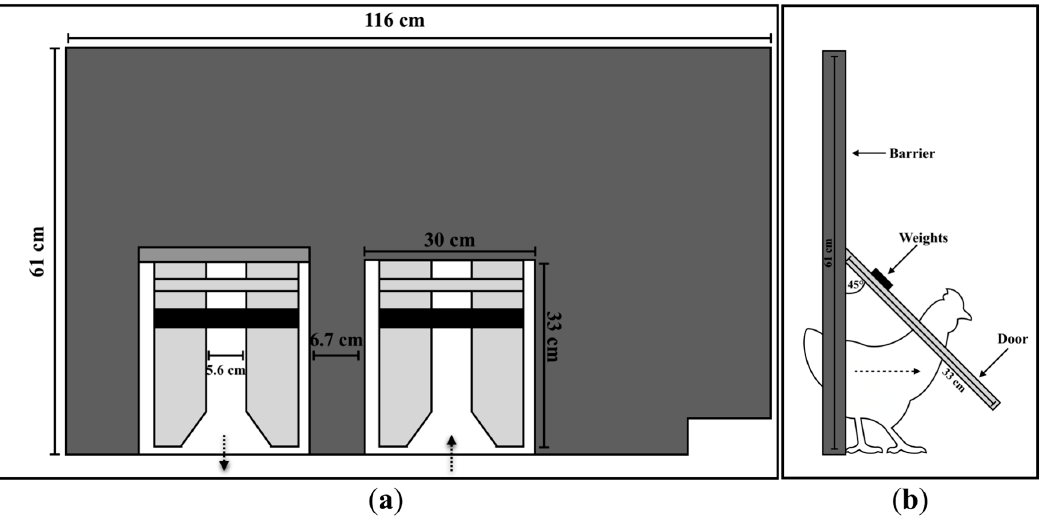
Figure 3. ( a ) Barrier layout with push doors viewed from chicks’ eye level. Each barrier contained two one-way push doors. Weights are shown as black bars that mount just above where the chicks’ heads would be when pushing the door. ( b ) The door rests on the chick’s shoulders as she pushes